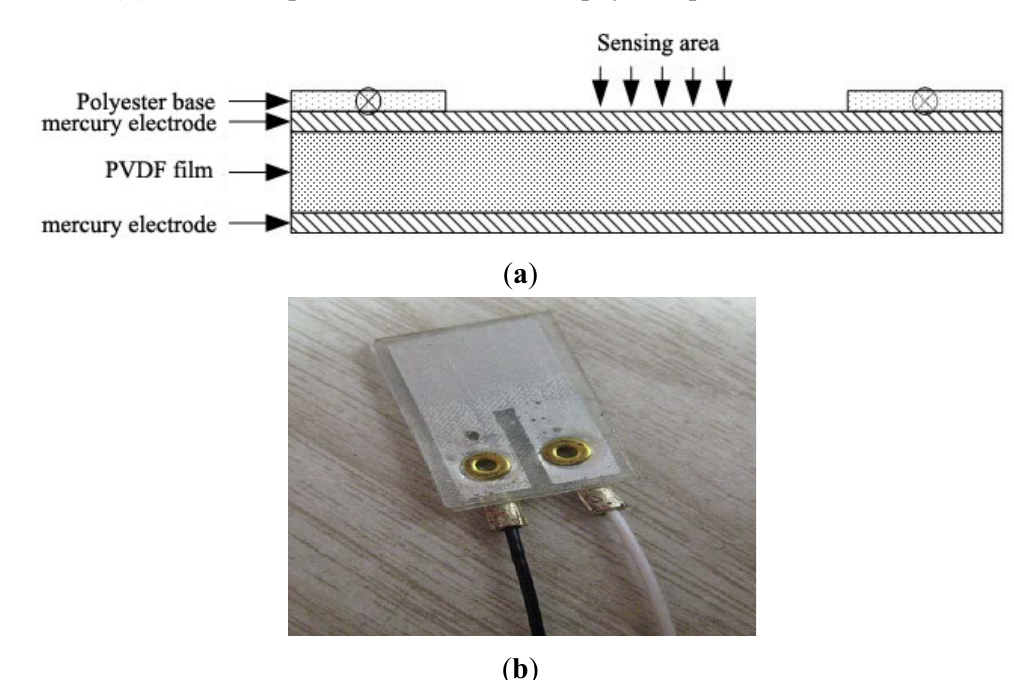
Figure 2. PVDF piezoelectric sensor: ( a ) schematic structure of PVDF foil piezoelectric transducer; ( b ) PVDF foil piezoelectric transducer physical picture.